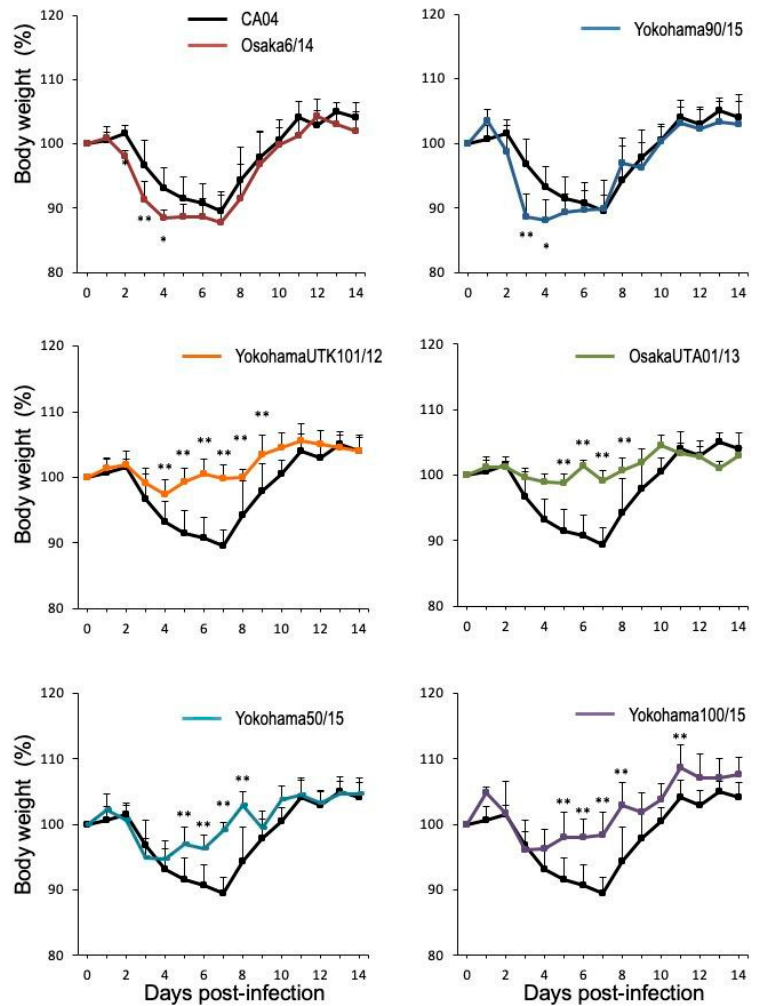
Figure 2. Body weight changes of mice infected with Japanese isolates or with CA04 / 09. Mice (five per group) were infected intranasally with 10 5 PFU of each virus. Asterisks indicate the timepoints at which mice infected with Japanese isolates showed greater or smaller body weight loss than mice infected with CA04 / 09 (*, p < 0.05; **, p < 0.01).